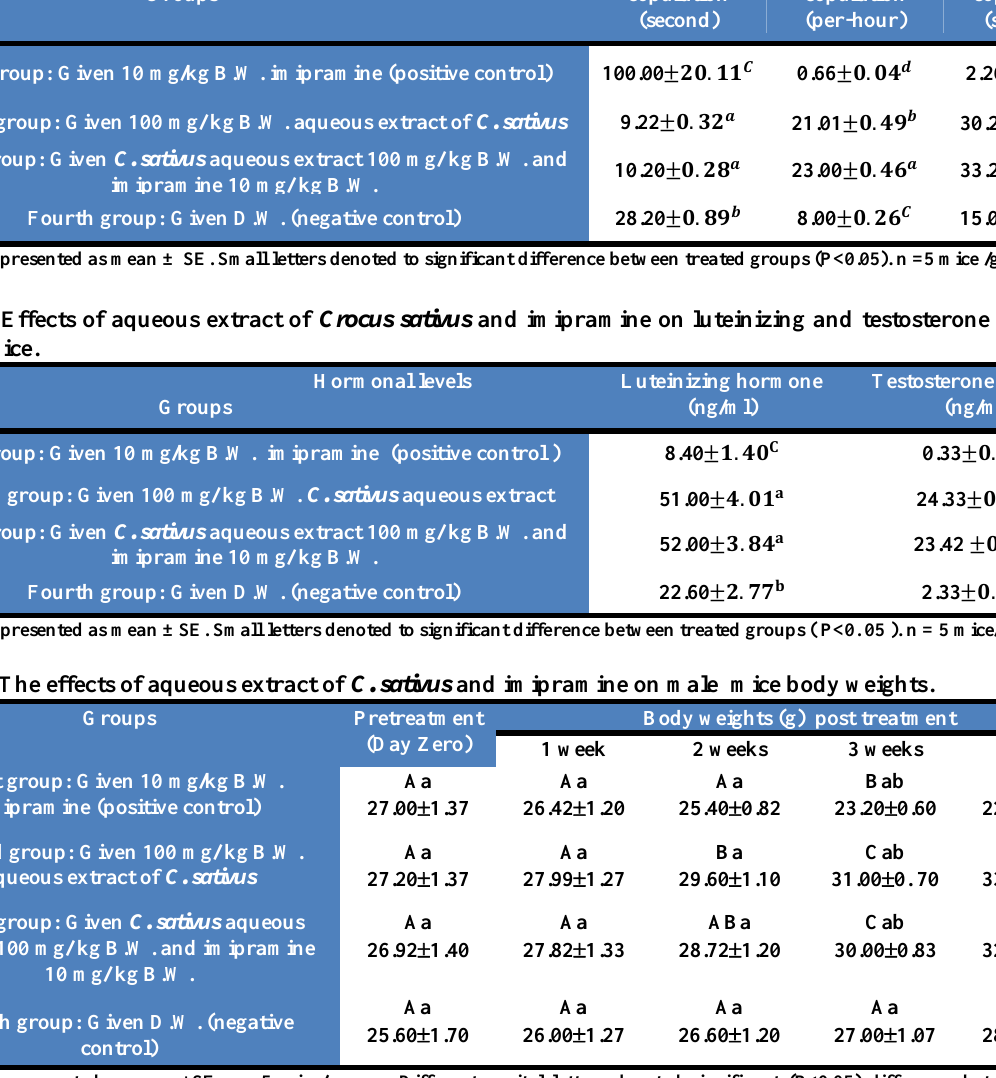
Latency of Frequency of Duration of copulation copulation copulation (second) (per-hour) (second)